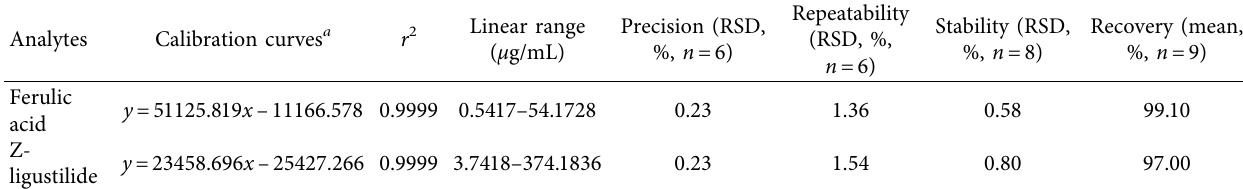
Table 2: The results of methodology validation for HPLC analysis.